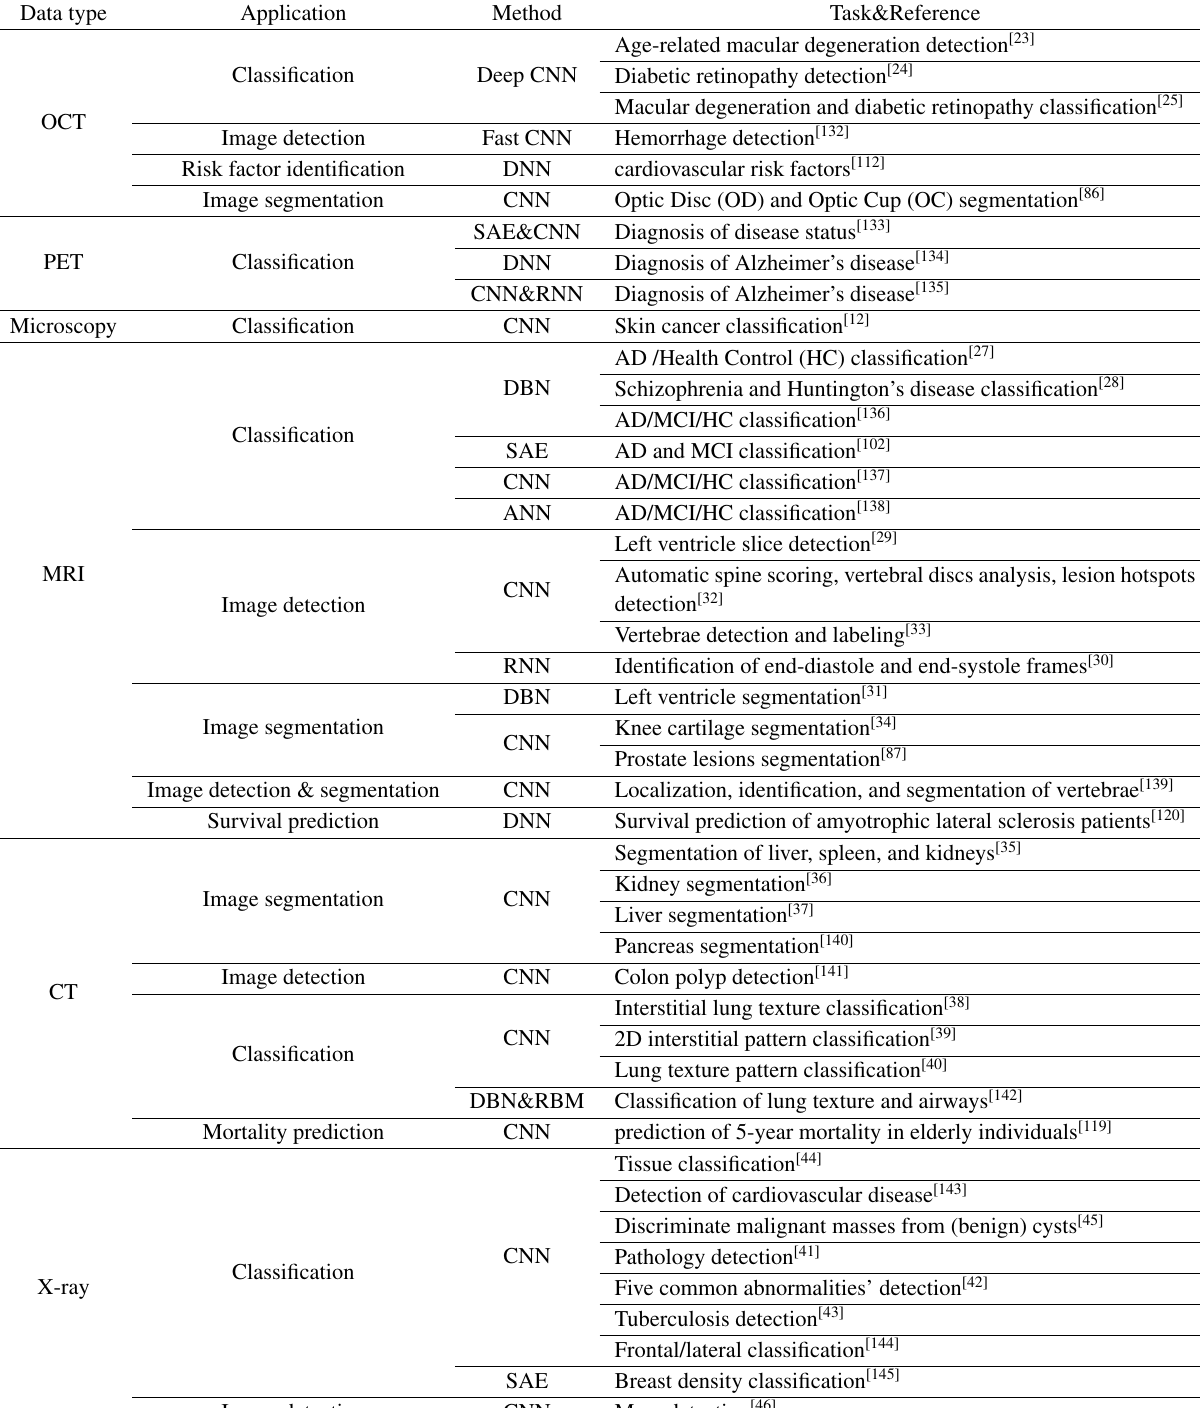
Table 2 Overview of deep learning methods applied on medical